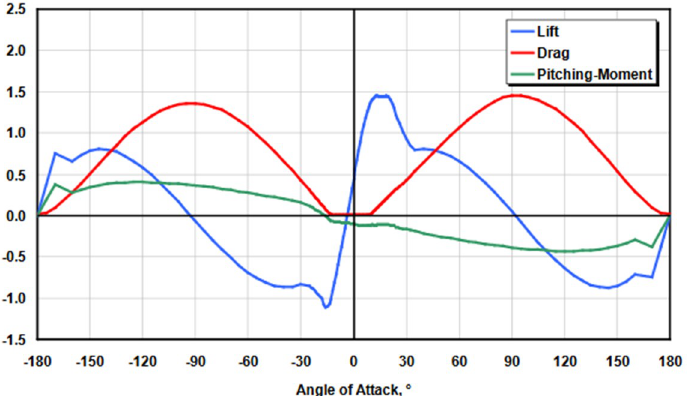
Figure 7. Coe ffi cients of the NACA64 airfoil [23] shown as the respective dimensionless coe ffi cient Figure 7. Coefficients of the NACA64 airfoil [23] shown as the respective dimensionless coefficient (y-axis) vs. angle of attack (y‐axis) vs. angle of attack (x‐axis).